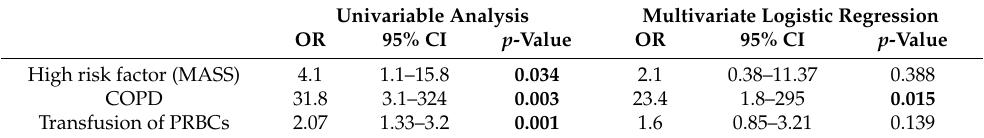
Table 5. Multivariate analysis.